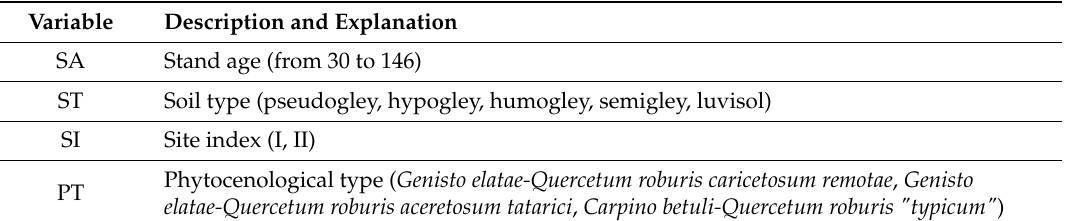
Table 4. Existing stand variables from Forest management plans (FMP variables) used as potential independent variables in statistical analysis (development of stand-level volume